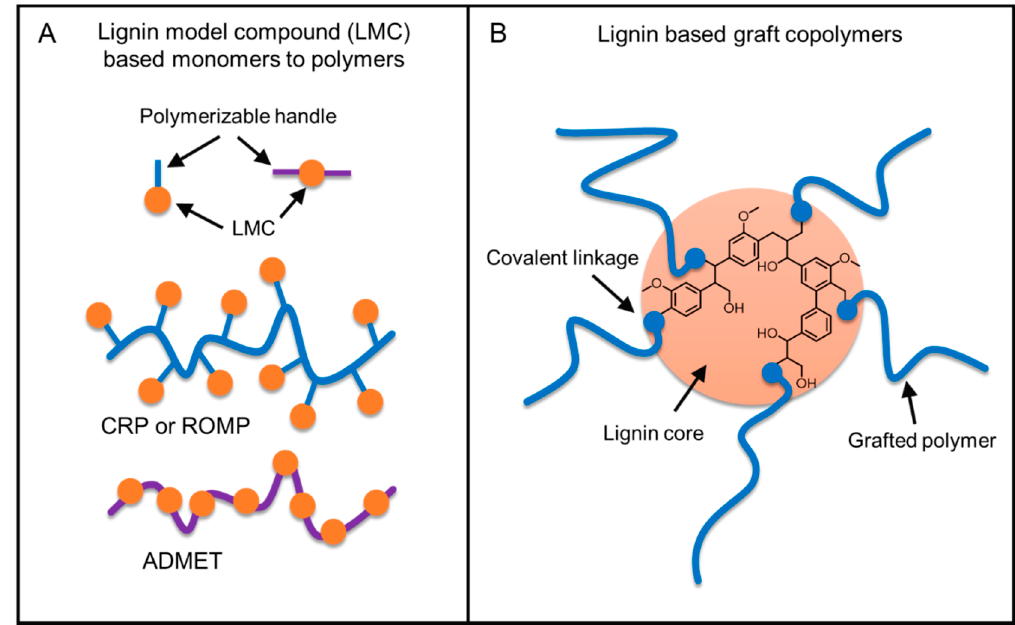
Figure 7. Strategies for lignin-based polymer synthesis.